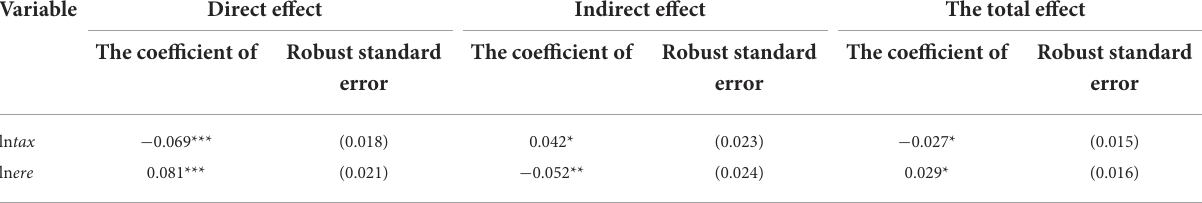
TABLE 5 Direct effect, indirect effect (spatial spillover effect) and total utility of spatial Durbin model.